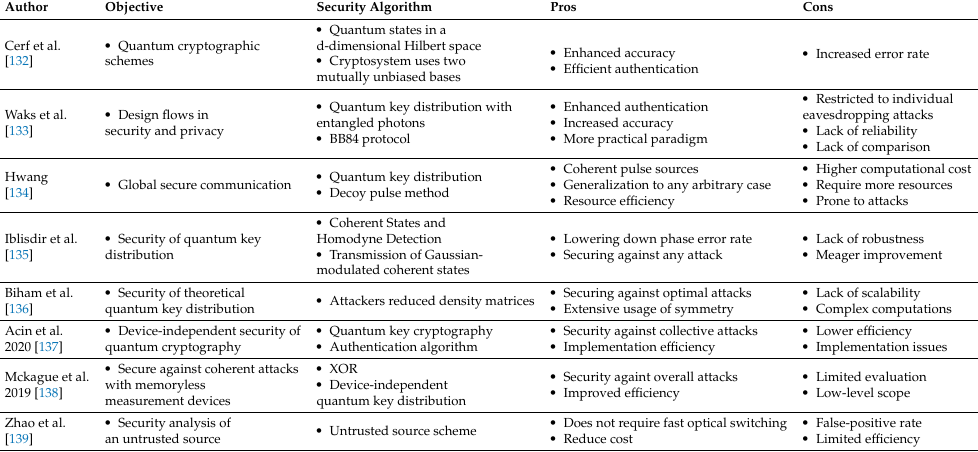
Table 5. Summary of countermeasures and security protocols using d-level systems